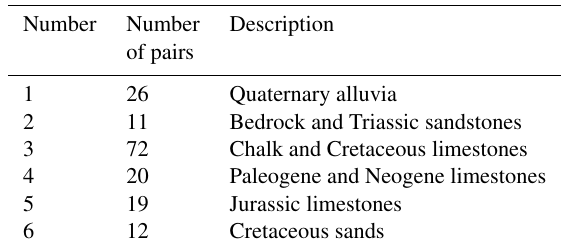
Table 3. Groups of catchment/piezometer pairs gathered by geolog- ical